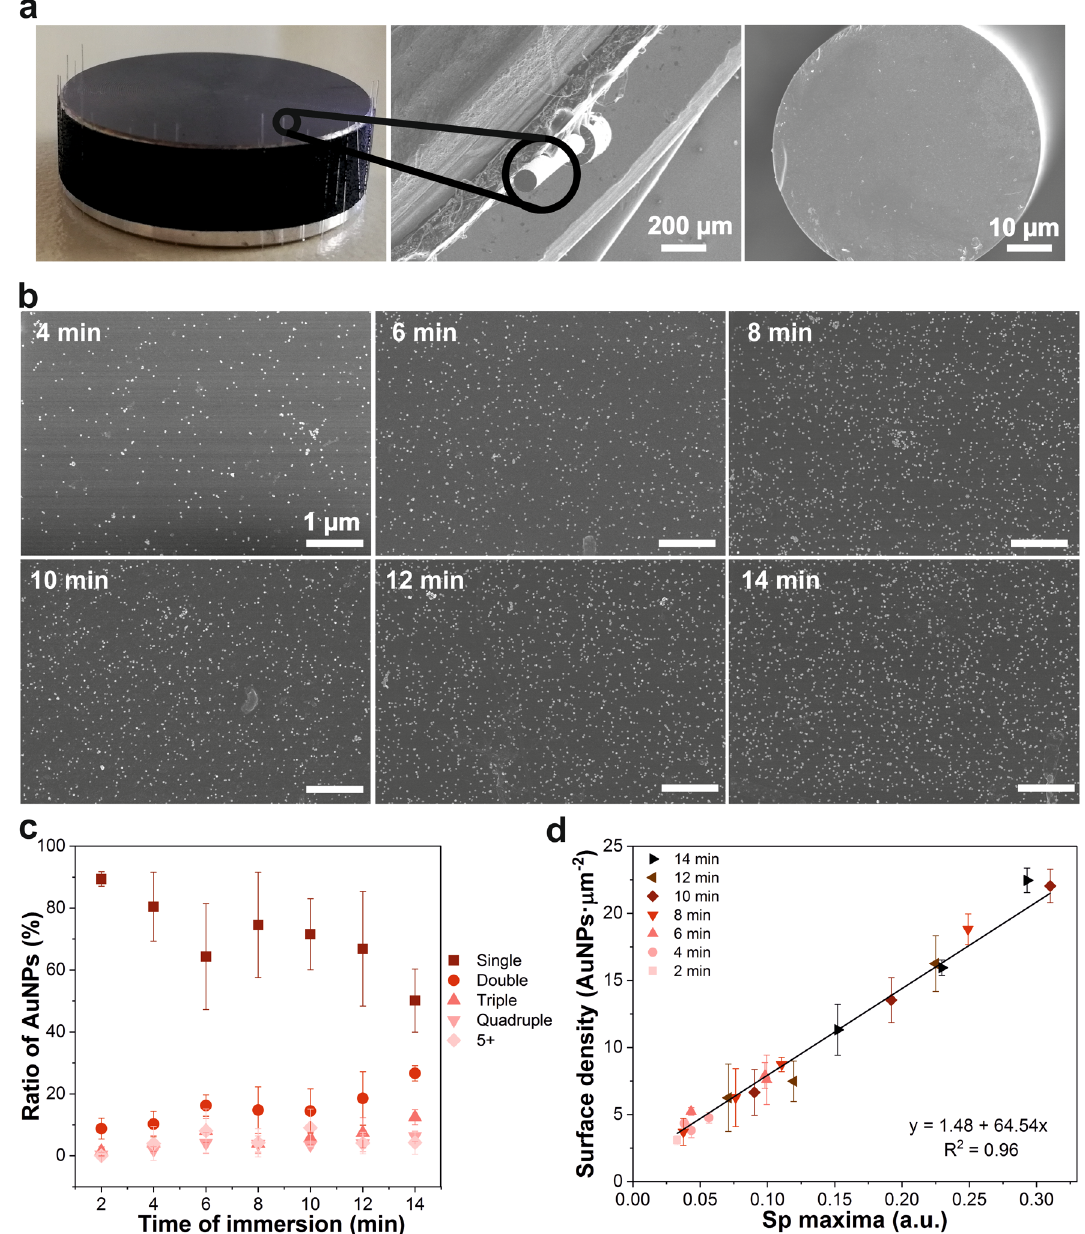
Figure 3. SEM characterization: correlation between AuNPs surface density and LSPR signal (Sp maximum values). ( a ) Pictures of the optical fibers stuck on the SEM sample holder, the view of a single optical fiber inside the SEM chamber and a detail of the fiber’s end face. ( b ) Representative SEM images for every immersion time (scale bar 1 µm). ( c ) AuNPs distribution values regarding whether each AuNPs was alone (single) or in contact with others (double, triple, quadruple and five or more aggregated nanoparticles) plotted against their respective times of immersion; error bars correspond to the standard deviation of the number of AuNPs present on the end faces from three different optical fibers for each immersion time (n = 3, except at 2 min, where only one fiber is represented with the deviation between its three pictures). ( d ) AuNPs surface density (nanoparticles per square micrometer) of the fibers immersed for different times, plotted against their respective Sp maximum values. Error bars correspond to the standard deviation of the number of AuNPs in three different SEM images from each optical fiber (n =